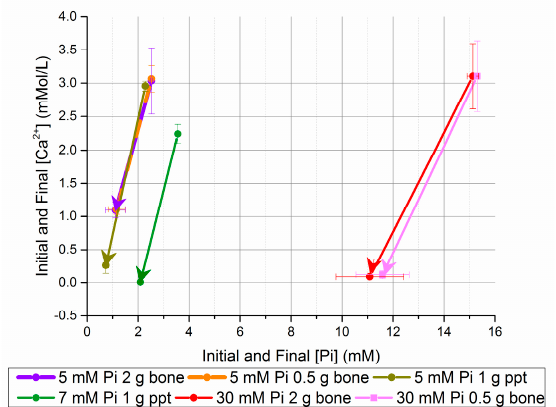
Figure 3. Change in [Ca 2+ ] and [Pi] after five days in seeded batch precipitation (bone and homogeneously nucleated precipitate (ppt)).